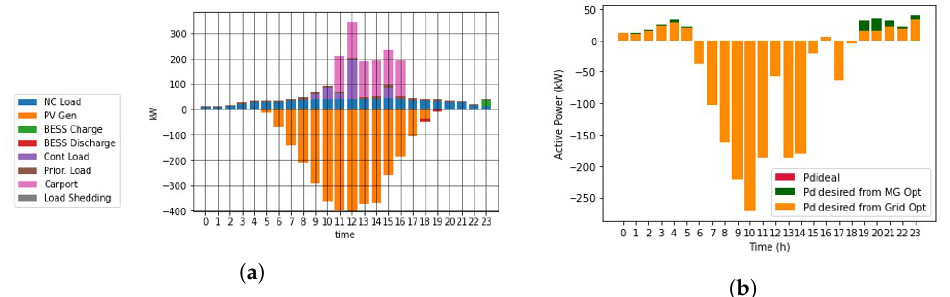
Figure 10. Proposed dispatch for the microgrid before the feedback process. ( a ) Dispatch of the microgrid (MGOM). ( b ) Dispatch from the point of view of the active network